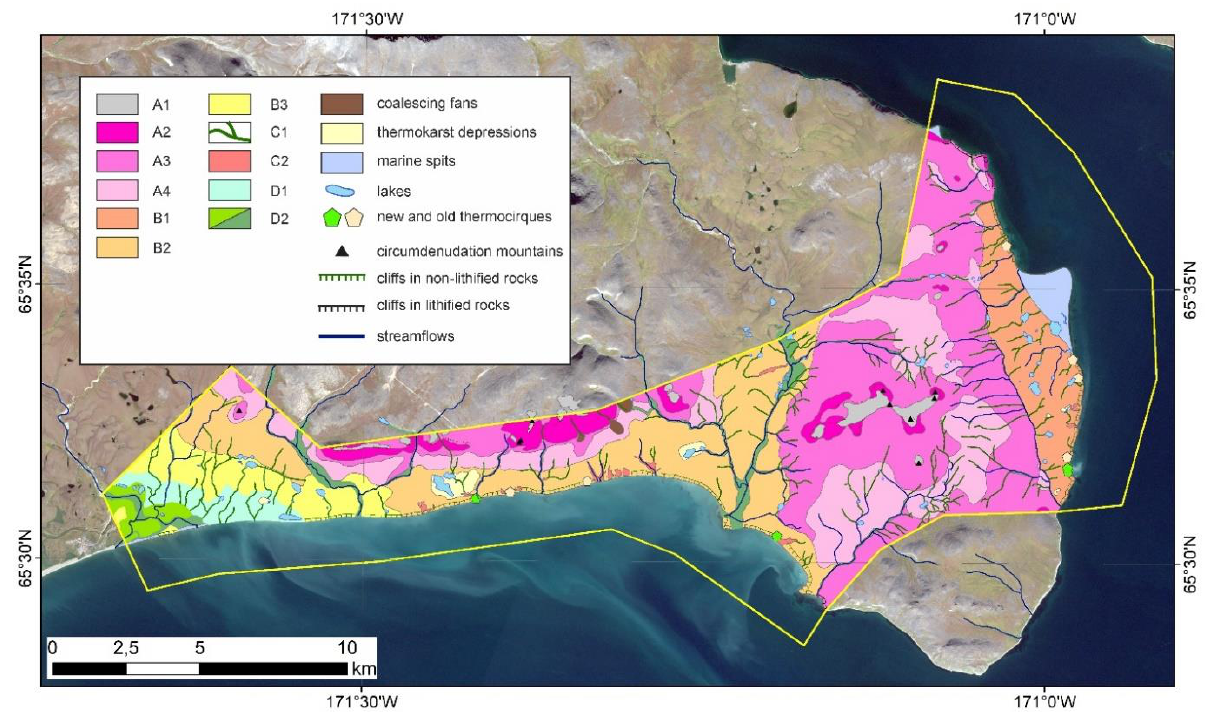
Figure 3. Geomorphology of the study area. Descriptions of the indices are given in the